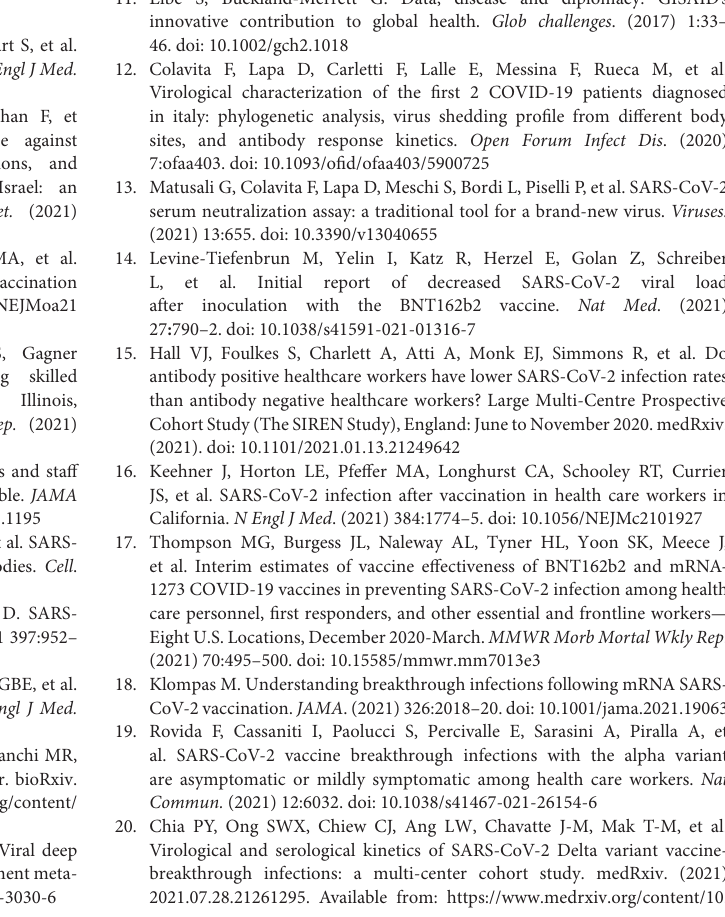
Supplementary Table S1 | Factors associated with positive viral cultures on NPS collected from vaccinated individuals at the time of SARS-CoV-2 diagnosis. Supplementary Table S2 | Vaccinated individuals with available matching data on antibody and RNA viral load. Supplementary Table S3 | Neutralising antibodies against different SARS-CoV-2